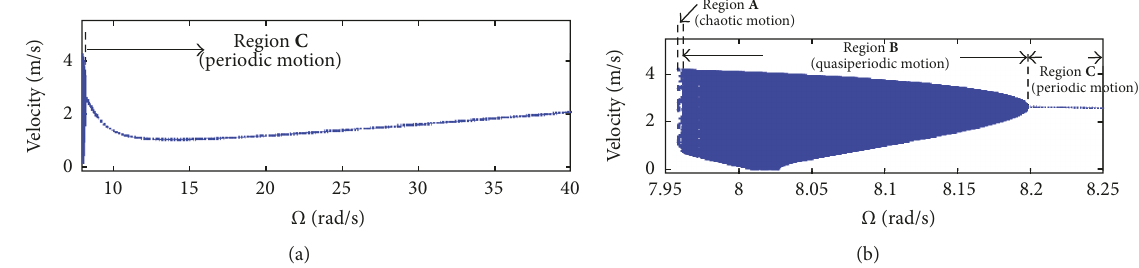
Figure 8: Bifurcation diagram for the system when the amplitude of the road excitation, ̃𝑎 , is 0.05 m: (a) Ω = 7.96rad/s to 40rad/s, (b) Ω = 7.96 rad/s to 8.25 rad/s.